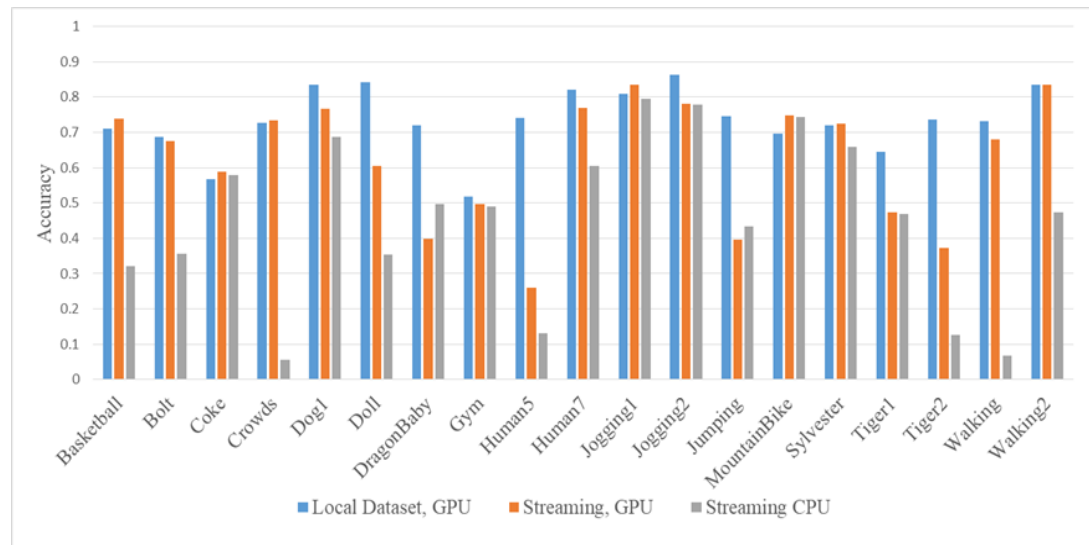
Figure 9. Accuracy evaluation of MDNet based tracker under 3 conditions: local dataset with GPU processing, streaming sequences with GPU processing, and streaming sequences with CPU processing.